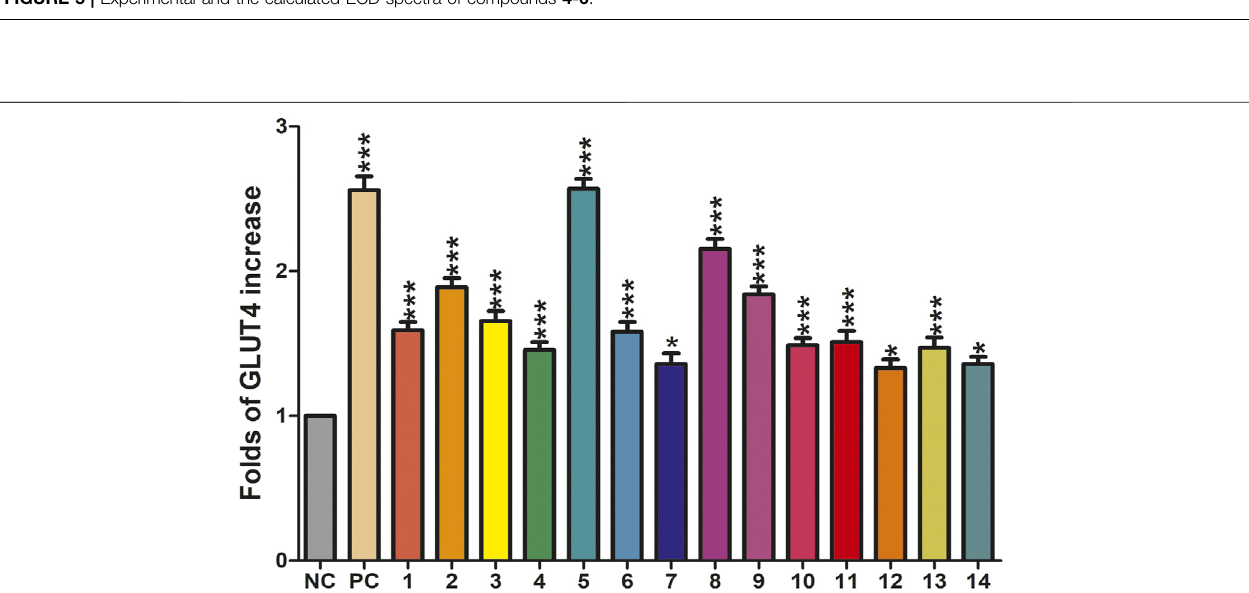
FIGURE6| EffectsoffourteencompoundsonGLUT4translocationinL6cells(* p < 0.05,comparedwithnon-treatedgroups(NC);*** p < 0.001,comparedwiththe NC group).